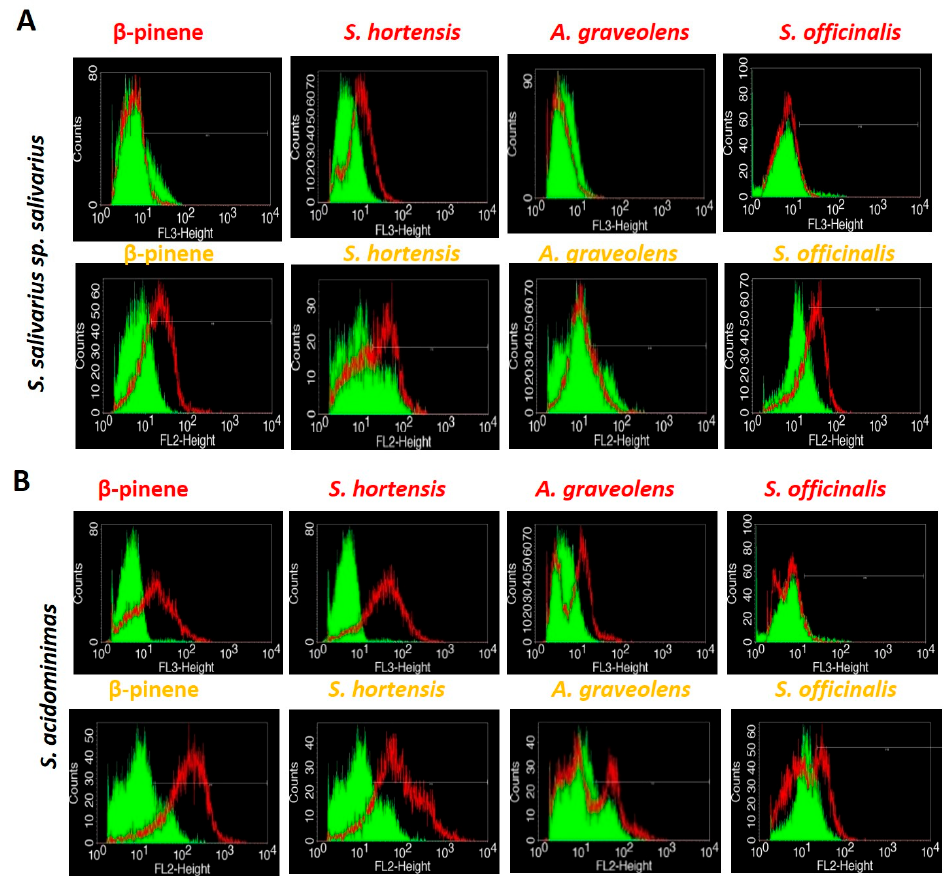
Figure 1. Histograms for Streptococcus salivarius sp. salivarius (panel A) and S. acidominimas (panel B) treated with volatile oils or analytical standard ( β -pinene) vs. a viable cell control (marked with propidium iodide (PI) (red) and ethidium bromide (EB) (orange)).